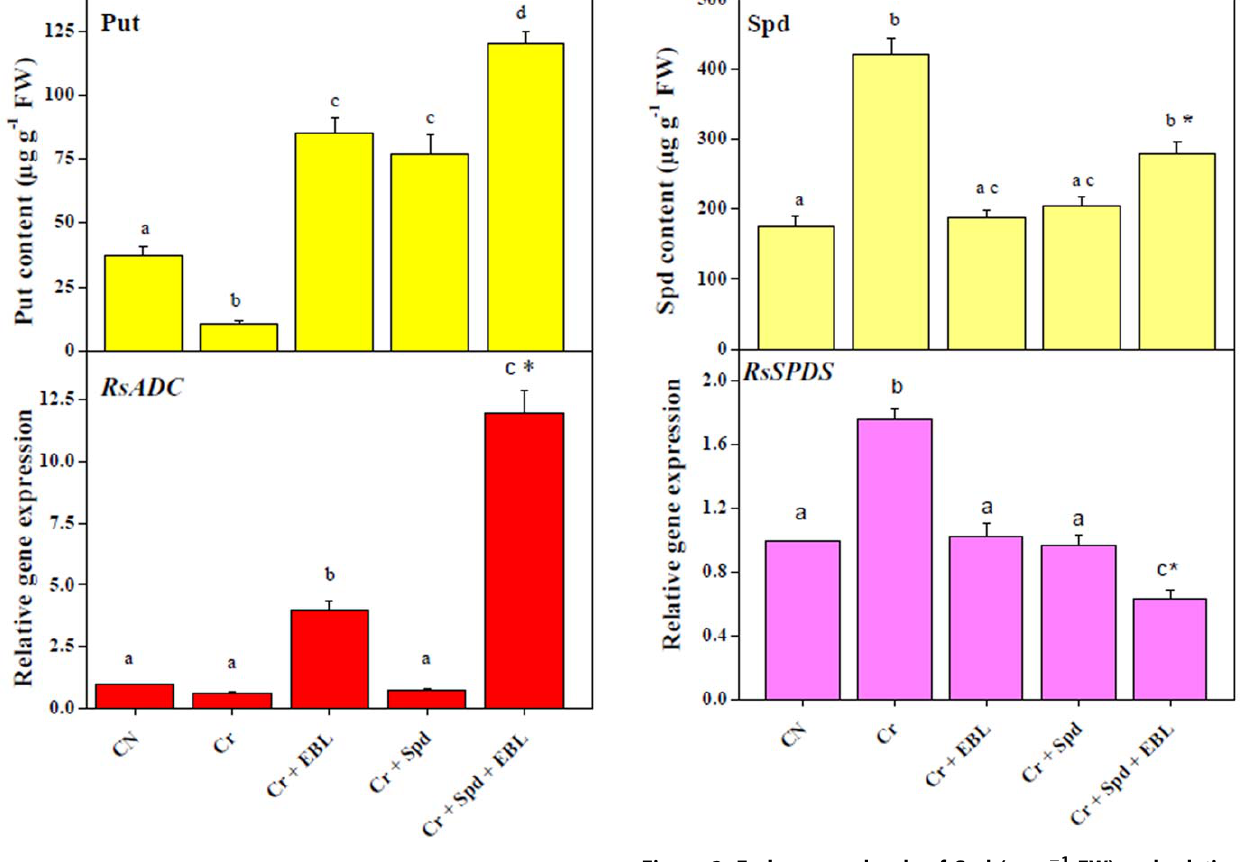
Figure 1. Endogenous levels of Put ( m g g 2 1 FW) and relative expression of RsADC in 7-d-old radish seedlings under Cr-stress without or with EBL and/or Spd. Data are presented as mean 6 SE. Different superscripted letters (a, b, c, d) indicate significant difference from each other in all combinations (Tukey’s test, p , 0.05). Asterisk ‘‘*’’ indicates significant difference for EBL + Spd vs. EBL under Cr-stress (Tukey’s test, p , 0.05). doi:10.1371/journal.pone.0033210.g001 untreated control (Figure 3). EBL and Cr-stress treatment was able to improve free (4.12-fold) and bound (3.14-fold) IAA levels when